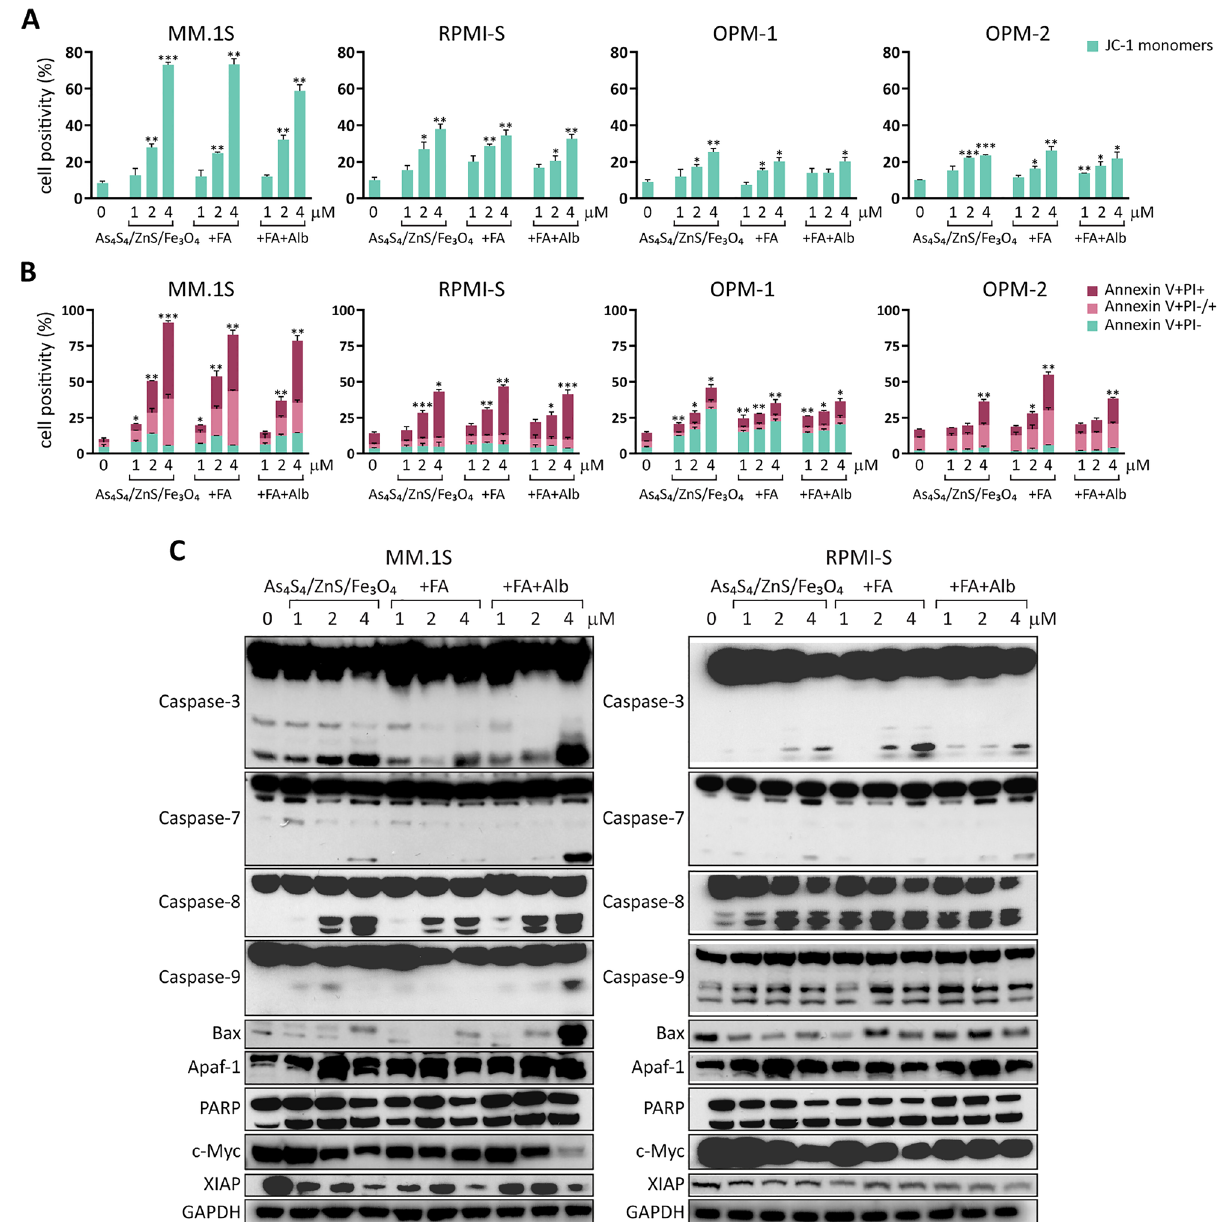
Figure 2. As 4 S 4 /ZnS/Fe 3 O 4 (1:4:1), As 4 S 4 /ZnS/Fe 3 O 4 (1:4:1) with FA, and As 4 S 4 /ZnS/Fe 3 O 4 (1:4:1) with FA and Alb trigger apoptosis and induce apoptosis-associated signaling in MM cells. MM.1S, RPMI-S, OPM-1, and OPM-2 cells were cultured with all 3NPs at 1, 2, and 4 µM for 48 h. ( A ) Depletion of mitochondrial membrane potential in 3NPs-treated MM cell lines was quantified by straining with the fluorescent JC1 dye by increased levels of JC1 monomers, and analyzed by a FACS Canto II flow cytometer. Data are from three independent experiments. ( B ) Effects of all 3NPs on induction of apoptosis and necrosis were evaluated with Annexin V-FITC and PI staining. Percentages of early apoptotic (Annexin V-FITC +/PI −), late apoptotic (Annexin V +/PI +/−) and necrotic (Annexin V +/PI+) cells were analyzed by a FACS Canto II flow cytometer. Data are from two independent experiments, presented as mean ± standard deviation. Significant differences between treatments and control were identified by t-test with * p < 0.05, ** p < 0.01, and *** p < 0.001. ( C ) MM.1S and RPMI-S cells were cultured with all 3NPs at 1, 2, and 4 µM for 48 h. Whole cell lysates (20 μg of proteins/lane) were subjected to western blot analyses using anti-caspase-3, -caspase-7, -caspase-8, -caspase-9, -Bax, -Apaf-1 (apoptotic protease activating factor-1), -PARP, -c-Myc, and -XIAP (x-linked inhibitor of apoptosis) antibodies. GAPDH served as a loading control. Results are representative of two independent